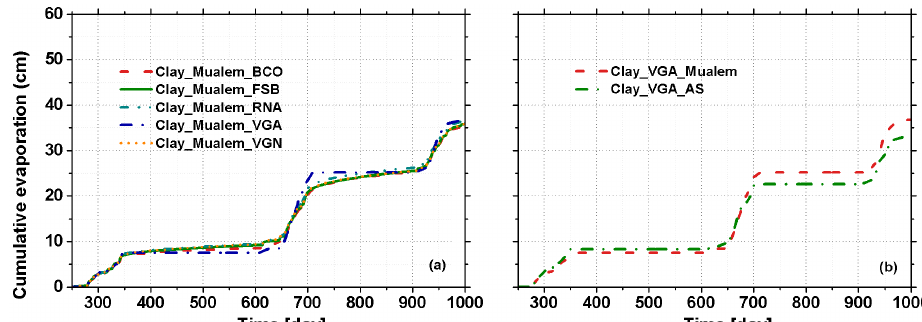
Figure 17. As in Fig. 14, for